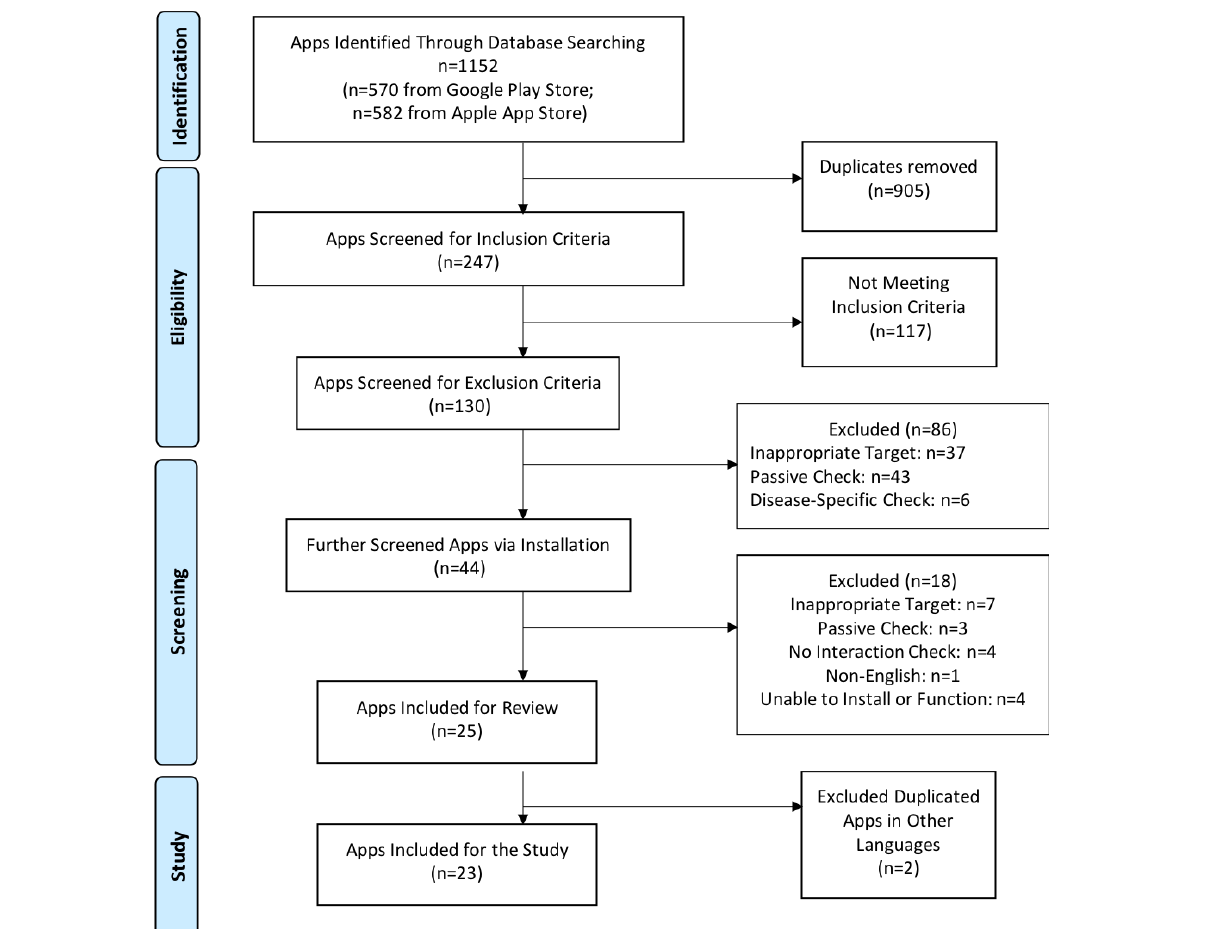
Figure 1. App selection